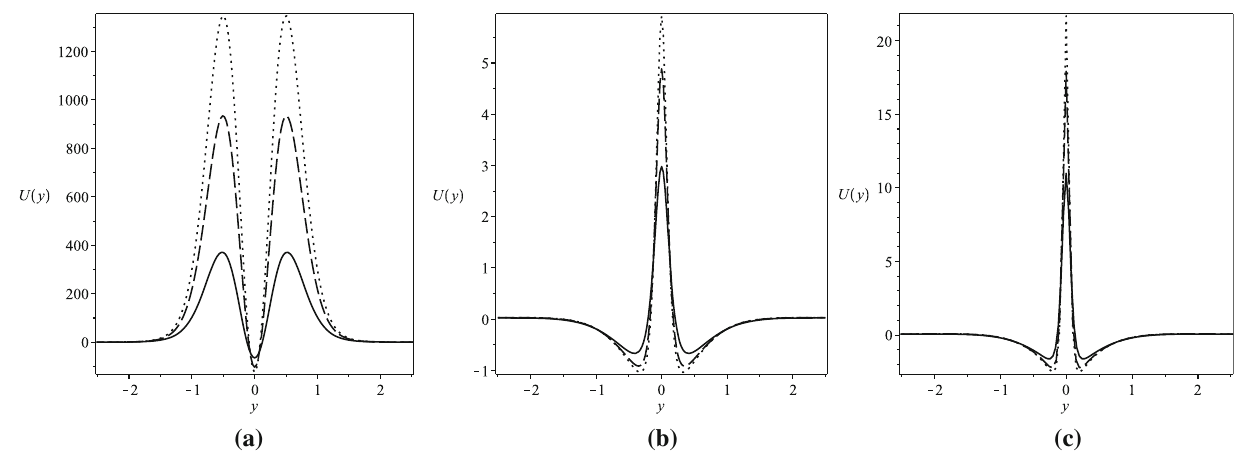
) . In all figures 2 − T